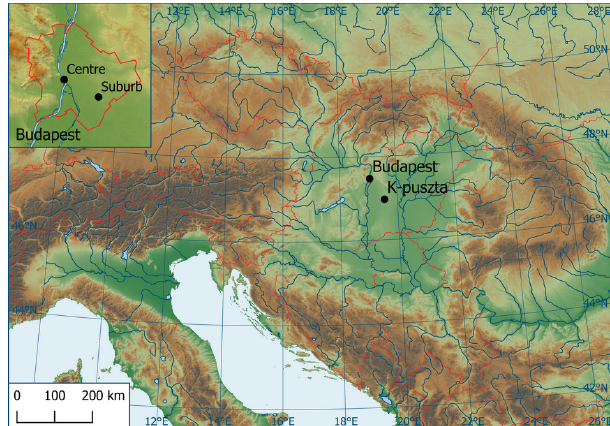
Figure 1. The Carpathian Basin with location of the sampling sites in Budapest (city centre and suburban area) and at K-puszta station (regional background). This image was created by © Mátyás Gede and used with his